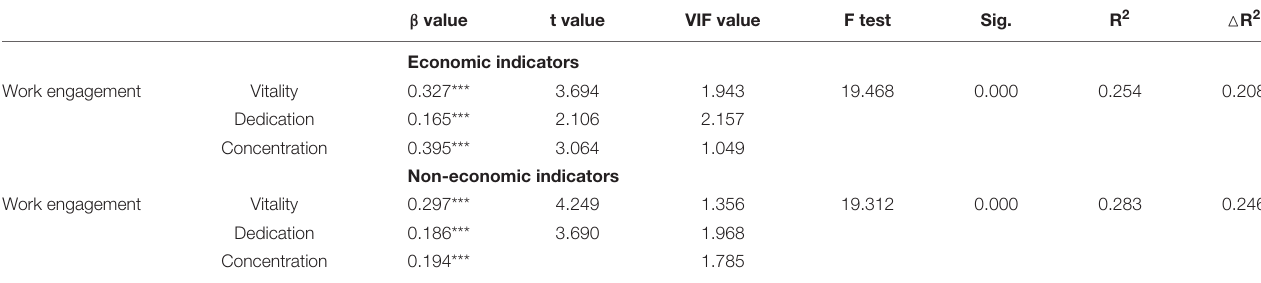
TABLE 4 | Regression analysis of work engagement and entrepreneurial performance at all